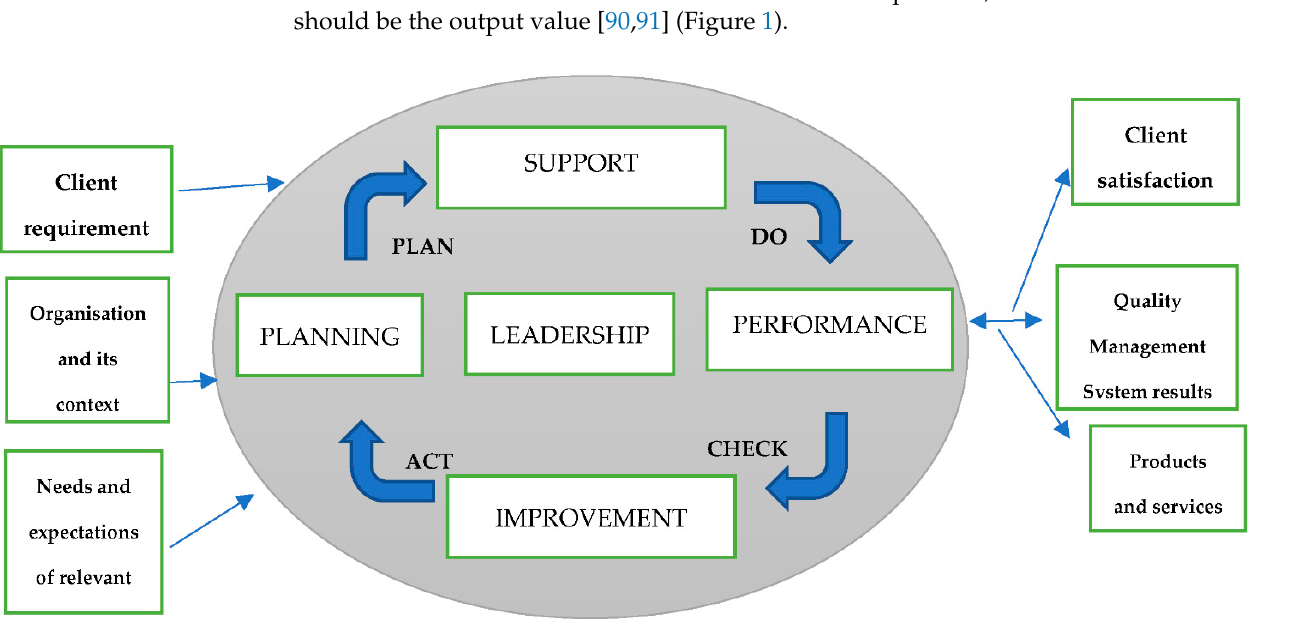
Figure 1. Quality management model (QMS) ISO 9001:2015. Source: [88,92,93].